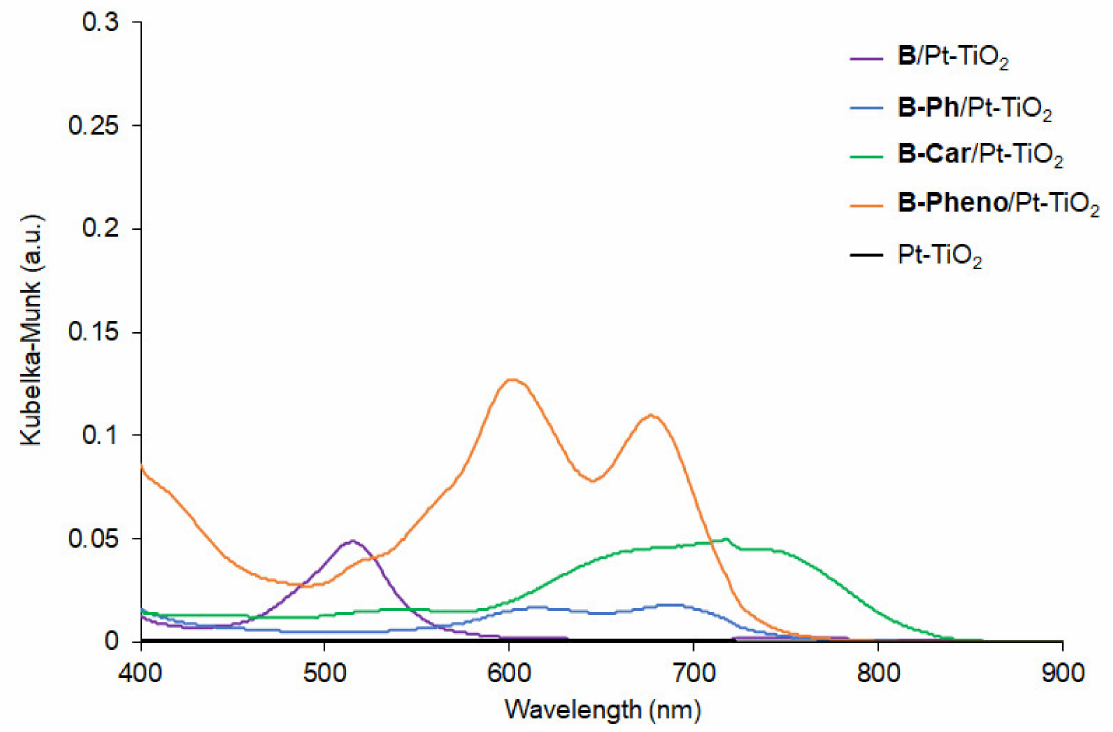
Figure 4. Reflectance spectra of B, B-Ph , B-Car , and B-Pheno / Pt-TiO 2